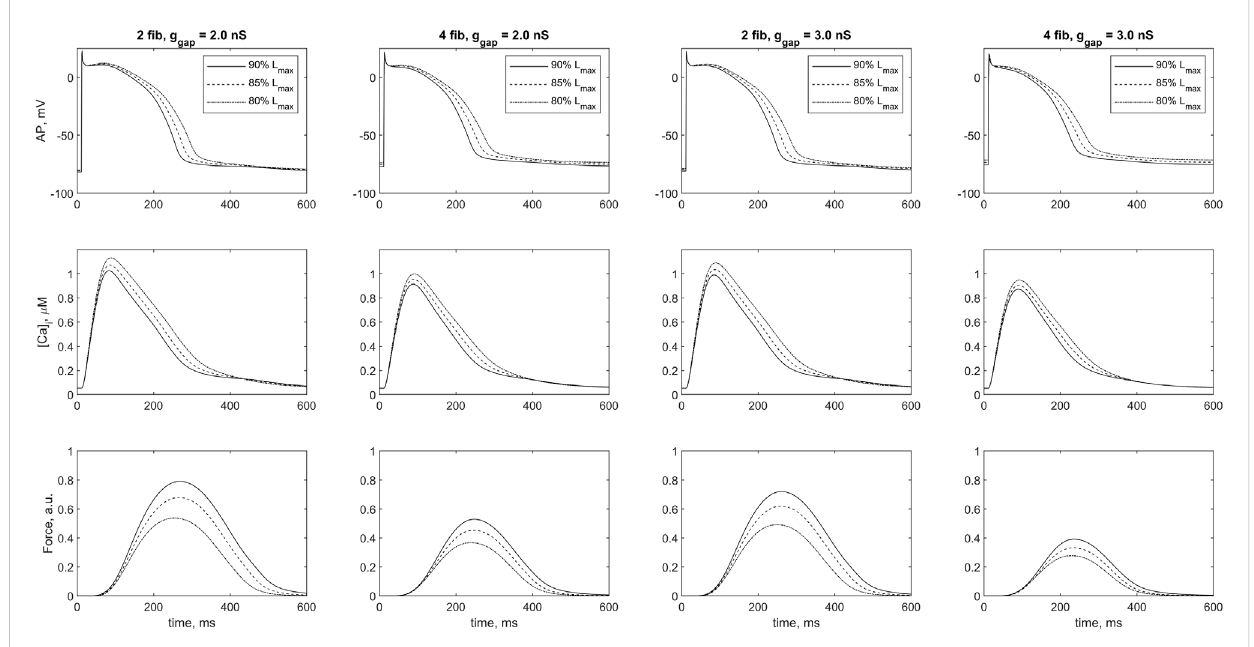
FIGURE 5 Cardiomyocyte action potential ( AP ), Ca 2+ transient ( [Ca] i ) and active force generated by the cardiomyocyte ( Force ) during a steady-state isometric twitches at different initial lengths in the case of 2 and 4 coupled fi broblasts for intercellular fi broblast-to-myocyte conductances ɡ gap of 2.0 nS and 3.0 nS in model 2 . The initial length of cardiomyocyte was set at 80%, 85% and 90% of L max (where L max is the length at which the peak active isometric force of the myocyte reaches the maximum value). The stimulation frequency was 1 Hz. Force values are normalized to the peak isometric force of the uncoupled cardiomyocyte.